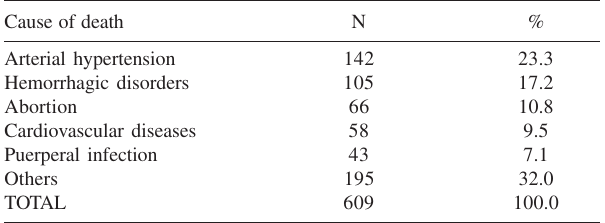
Table 1 - Distribution of the 609 cases of maternal death according to the main causes of death (São Paulo City, 1995-